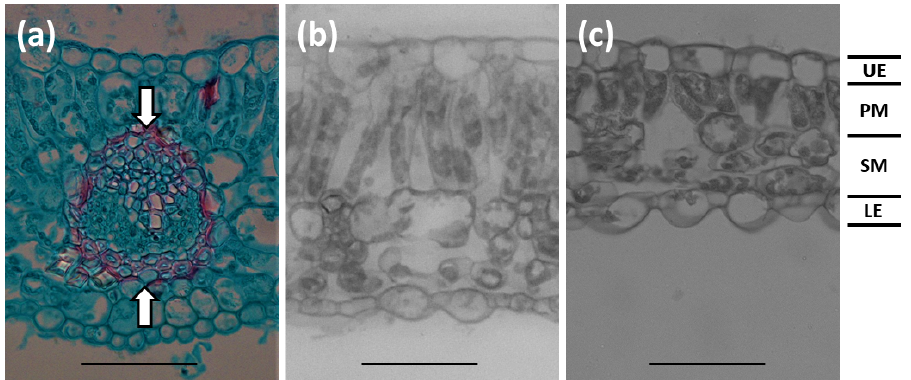
Figure 5. Serianthes nelsonii leaflet sections. ( a ) Midvein vascular bundle appearance. Distance between arrows were measured to quantify midvein thickness. ( b ) Section of plants grown in 100% sunlight. ( c ) Section of plants grown in 6% sunlight transmission. UE = adaxial epidermis; PM = palisade mesophyll; SM = spongy mesophyll; LE = abaxial epidermis. Bars = 50 μ m.